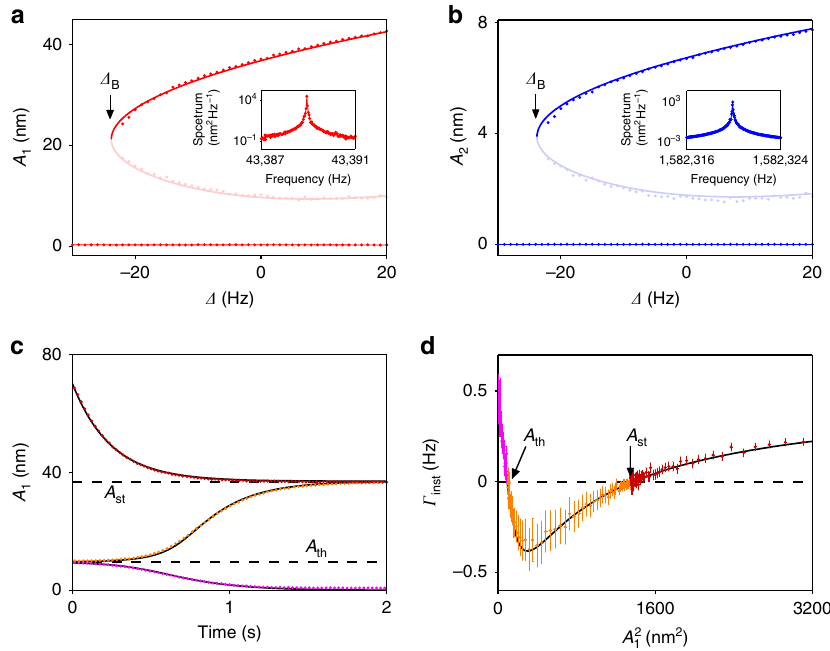
Fig. 3 Self-sustained vibrations associated with strong negative nonlinear friction. a Amplitude of vibrations of mode 1 as a function of pump detuning Δ . The stable branches are in red; they correspond to self-sustained vibrations and a zero-amplitude state. The light red dots represent the threshold amplitude for exciting self-sustained vibrations. The error bar is smaller than the dot size. Inset: spectrum of the self-sustained vibrations. b The same plot for mode 2. c Depending on the initial amplitude, mode 1 decays to zero (purple) or settle into self-sustained vibrations (orange and dark red). The two dashed lines mark the values of A st and A th . d The instantaneous decay rate extracted from ( c ). The solid lines in all panels are theoretical predictions (Supplementary Notes 2 and 3). Error bars represent ±1